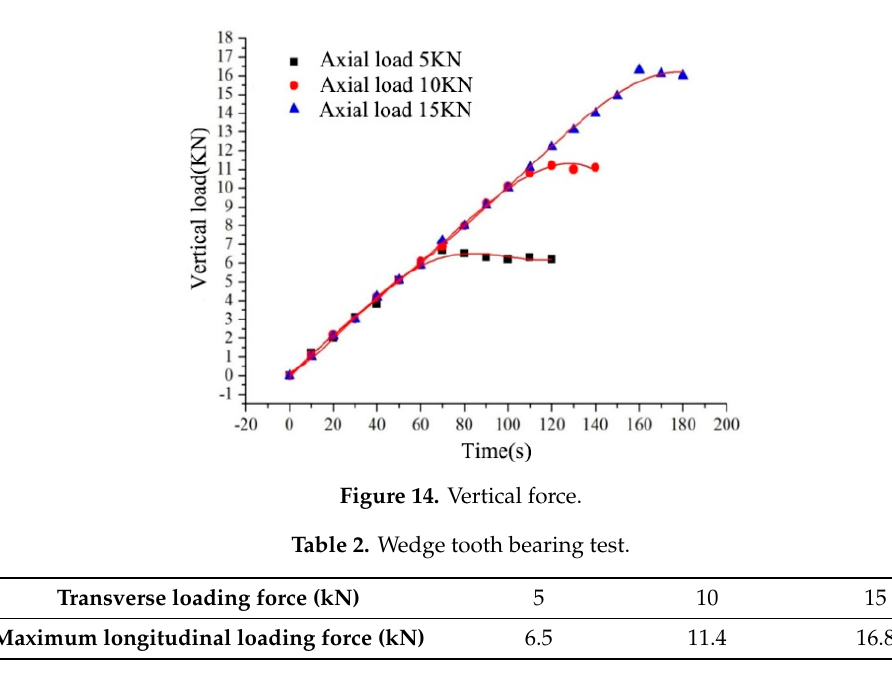
Figure 15. J. Mar. Sci. Eng. 2020 , 8 , x FOR PEER REVIEW